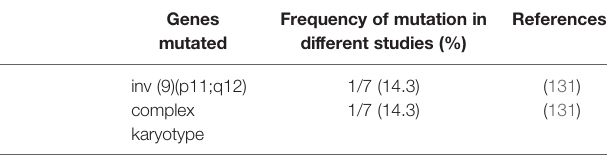
TABLE 1 | Summary of somatic mutations identi fi ed in ML – DS samples in addition to the mandatory GATA1s